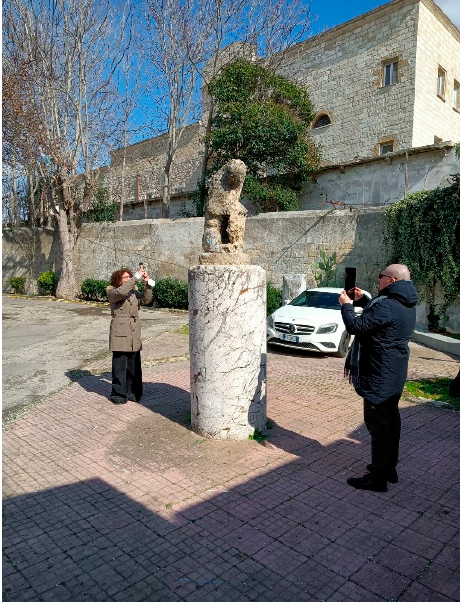
Figure 3. Survey of the statue (second test).